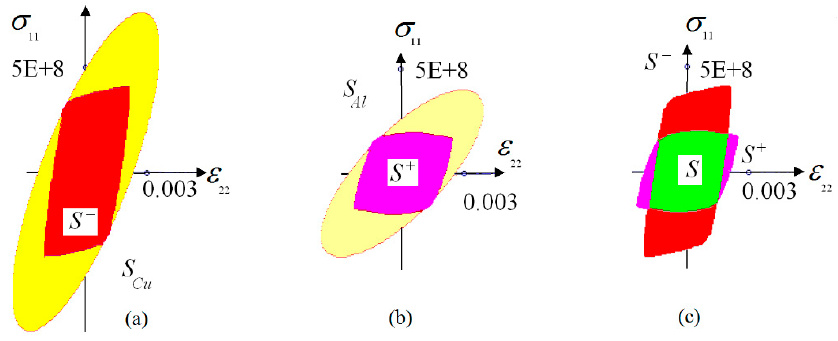
Figure 9. The failure curves for biaxial tension (( a ) cooper, ( b ) aluminum, ( c ) weld).